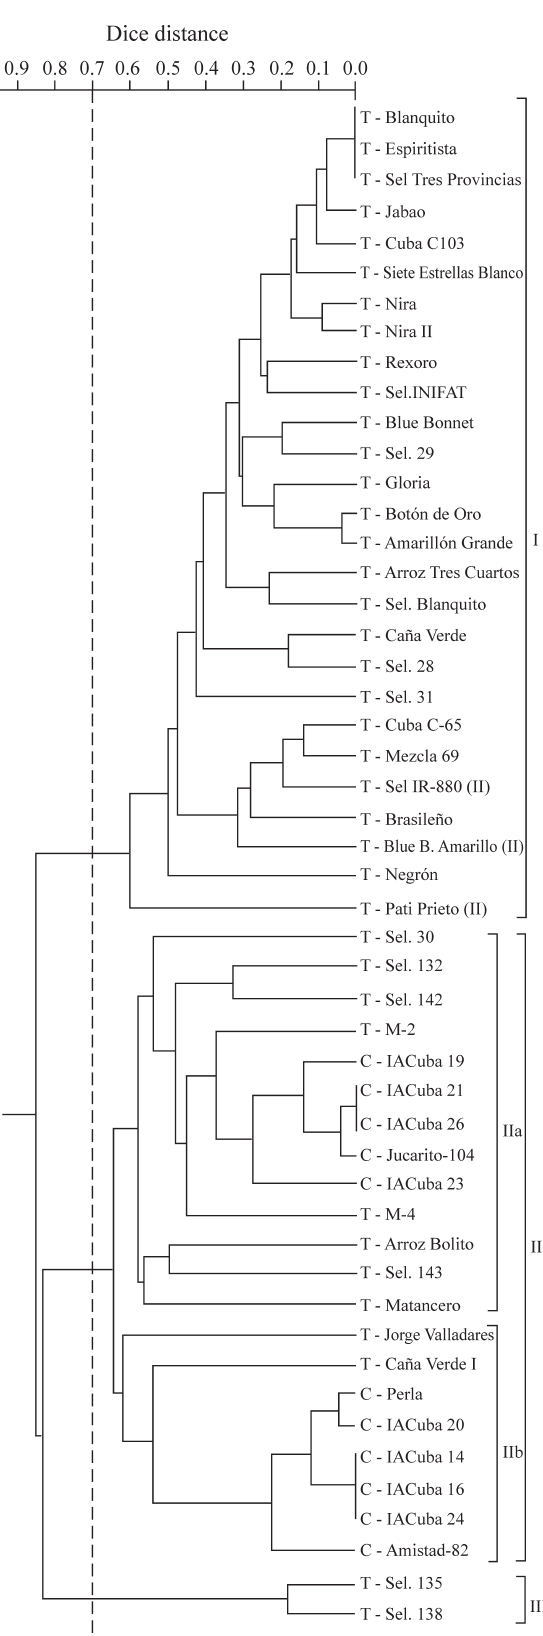
Figure1 -DendrogramofricevarietiesobtainedbyUPGMAclusteranal- ysis based on microsatellite